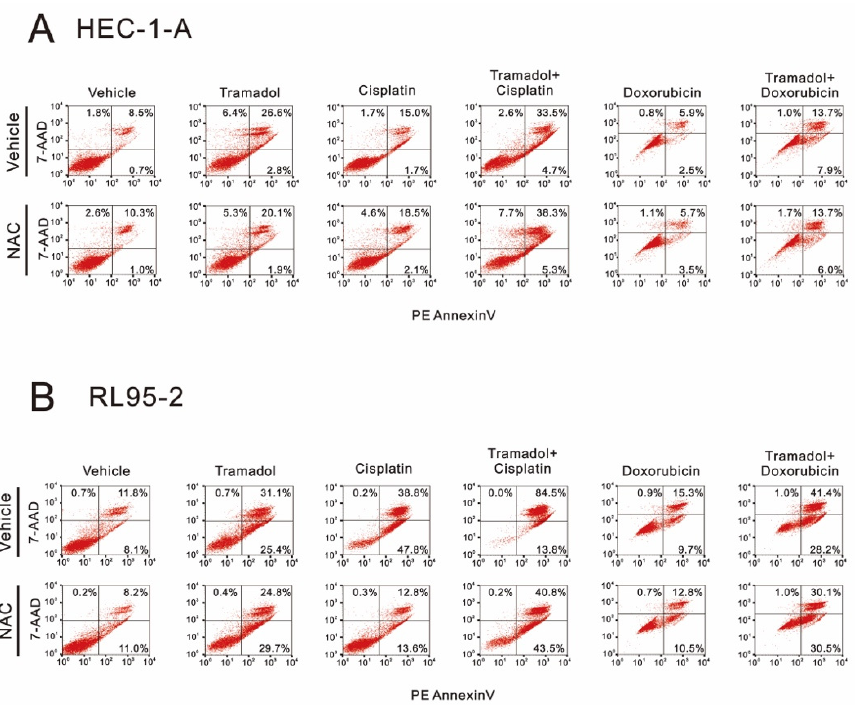
Figure 10. Effects of NAC pretreatment on tramadol-induced apoptosis of human endometrial cancer cells. ( A ) The vehicle groups of HEC-1-A cells were treated with 1 mg/mL tramadol, 128 µ M cisplatin, and 1.45 µ M doxorubicin for 24 h. The NAC groups were pre-treated with 5 mM NAC for 2 h. ( B ) The vehicle groups of RL95-2 cells were treated with 1 mg/mL tramadol, 7.2 µ M cisplatin, and 0.84 µ M doxorubicin for 24 h. The NAC groups were pre-treated with 5 mM NAC for 2 h.